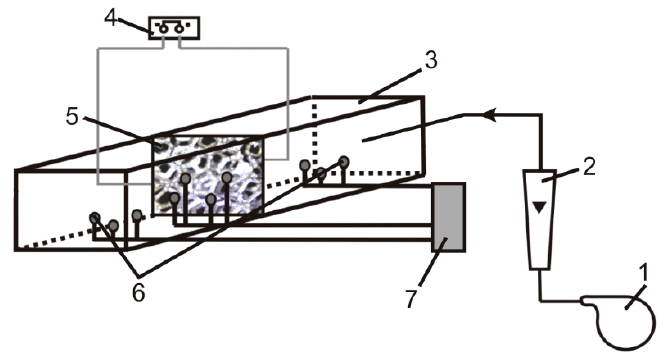
Figure 8. Experimental setup: 1—blower, 2—rotameter, 3—reactor, 4—electric power generation and control system, 5—solid foam, 6—thermocouple, 7—data acquisition system.